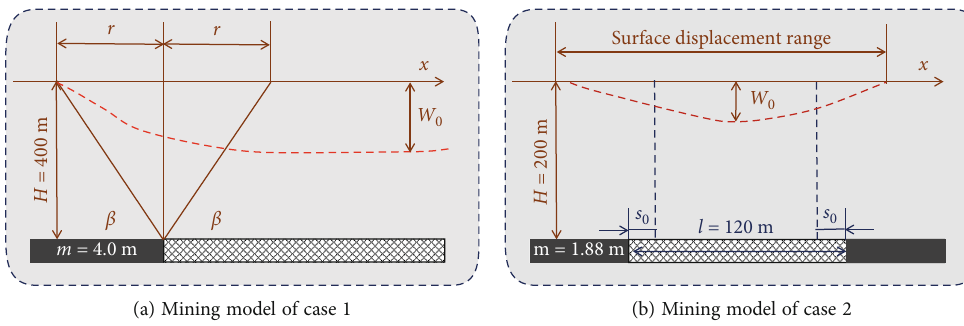
Figure 6: Case veri fi cation